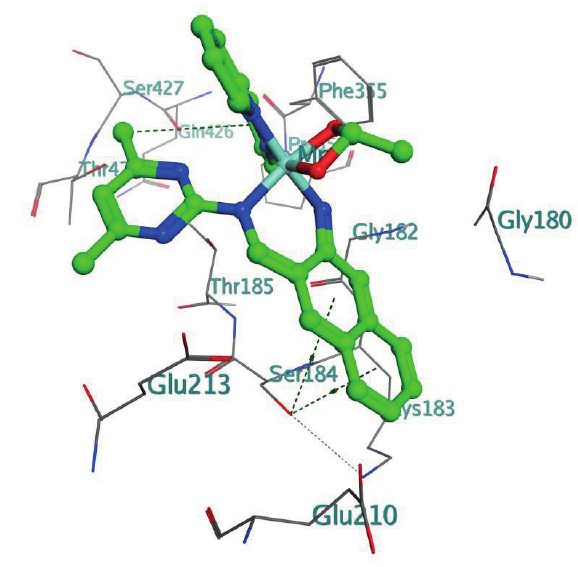
Figure 10: 2OBM-[Mn(L)(bipy)(OAc)] complex. Figure 10: 2OBM- [Mn(L)(bipy)(OAc)] complex. Figure 10: 2OBM- [Mn(L)(bipy)(OAc)] complex.